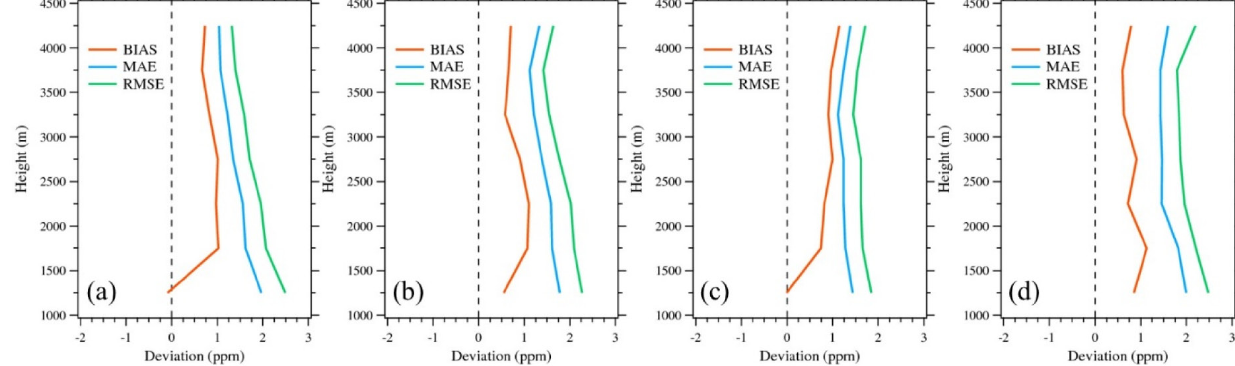
concentrations in all regions except East Asia, as well as at the MLO site. On global average (74 sites), the annual mean biases increase from − 0 . 36 ppm in 2010 to 0.75 ppm in 2019, with an uptrend slope of 0.115 ppm yr − 1 (Fig. S12). By mul-